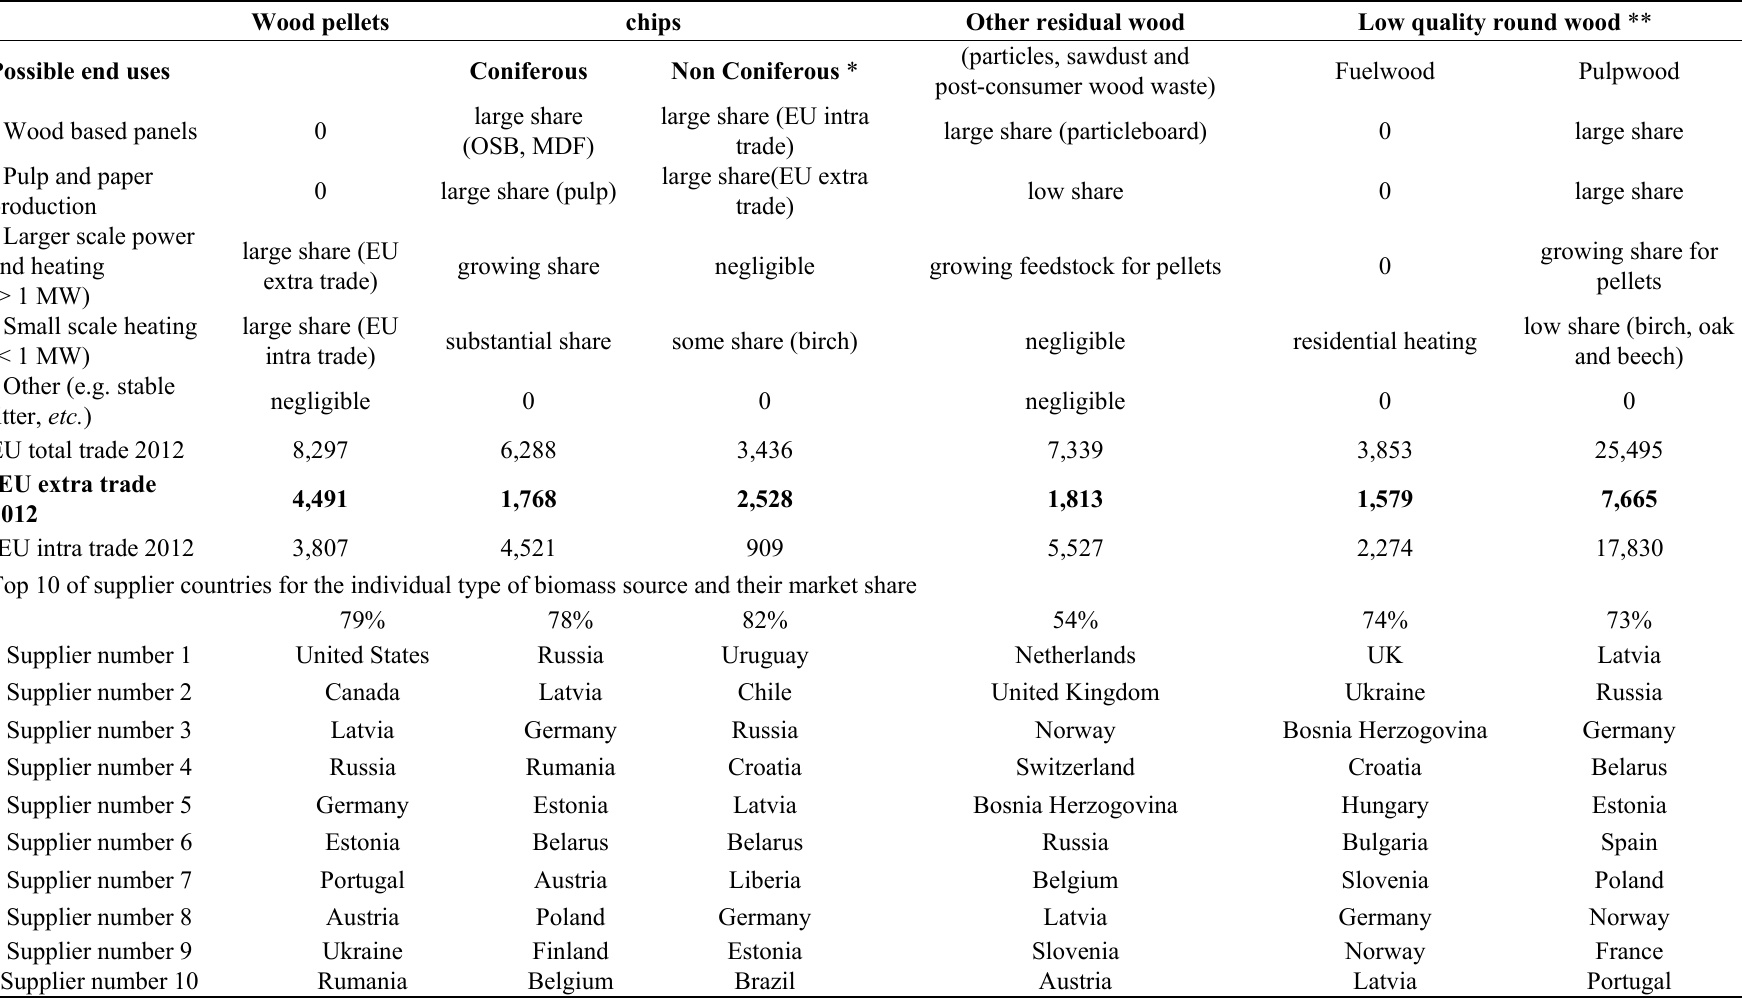
Table 1. EU intra and EU extra imports of low quality logs and possible other energy wood commodities—2012 (in 1000 tonnes)